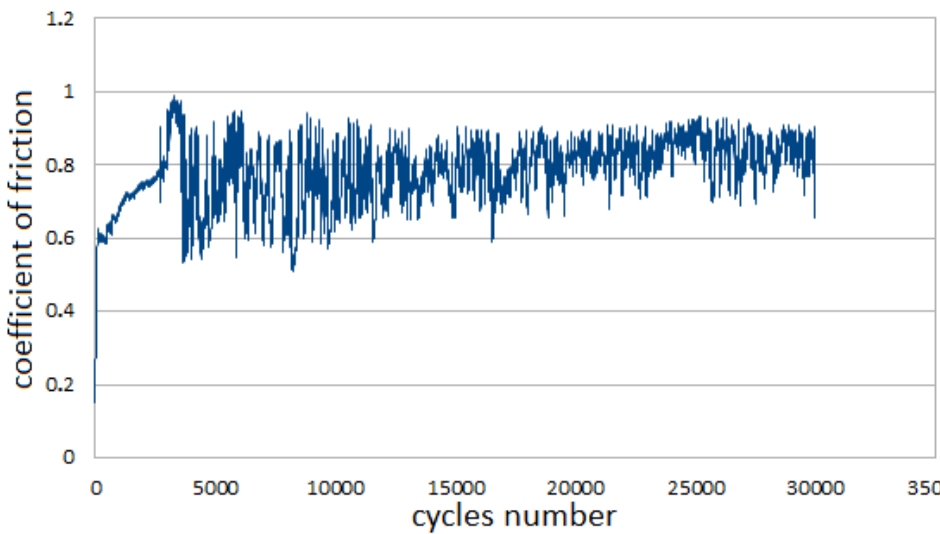
Figure 4. The coefficient of friction (CoF) dependence detected during the whole tribological test for the ATZ material during the test performed at 150 °C.